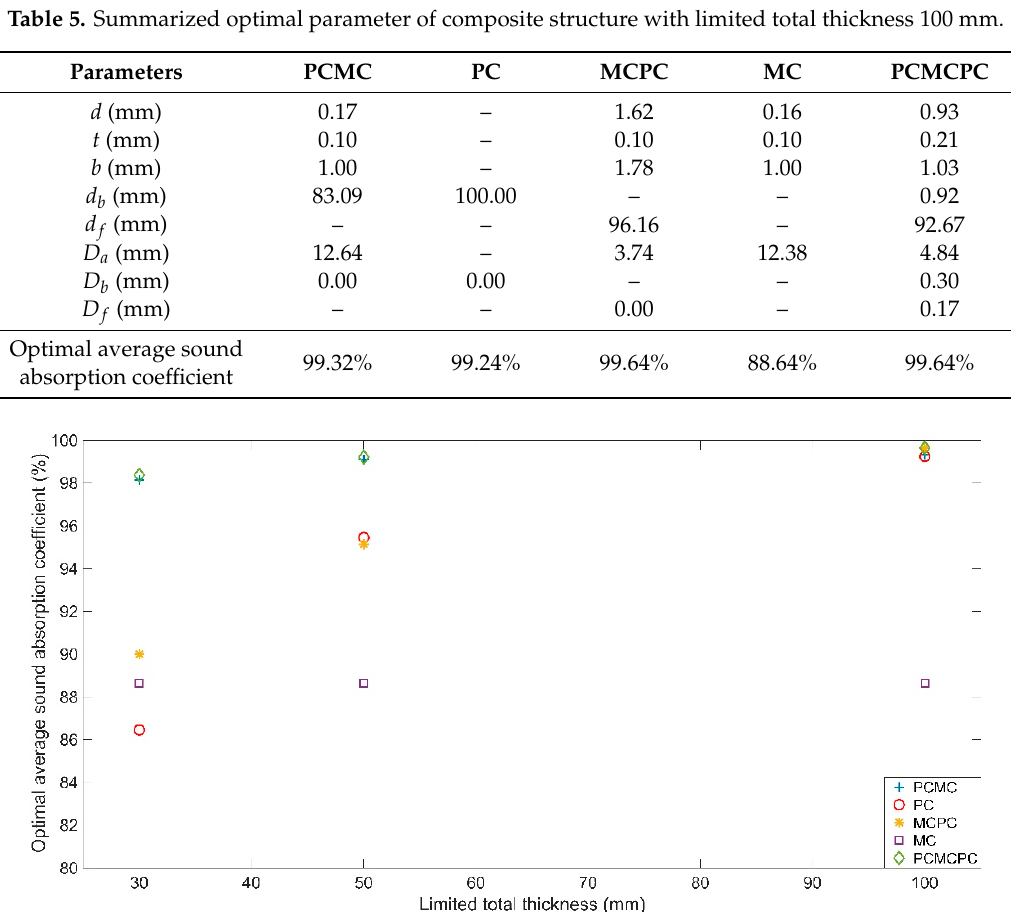
Table 5. Summarized optimal parameter of composite structure with limited total thickness 100 mm.